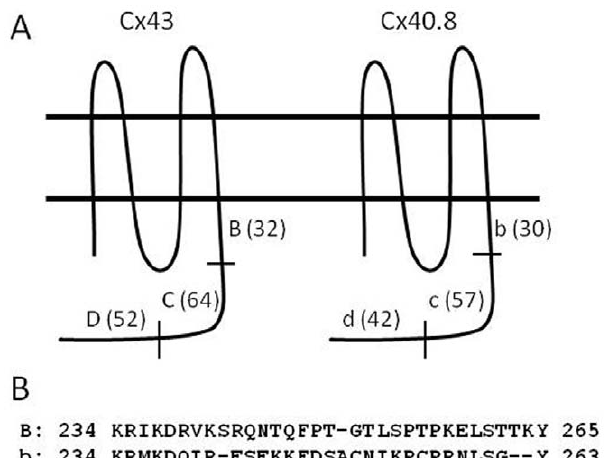
Figure 4. Cartoon illustrating different domains of Cx43 and Cx40.8 used to generate protein chimeras. (A) Full length sequences of Cx43 and Cx40.8. The amino terminus through the end of the fourth transmembrane-spanning domain was not modified. Swaps of the entire carboxy termini were generated, as well as swaps between domains B/b, C/c, and D/d. Uppercase refers to the Cx43 domains; lowercase refers to the Cx40.8 domains. (B) Amino acid sequence of Cx43-B vs. Cx40.8-b domains.